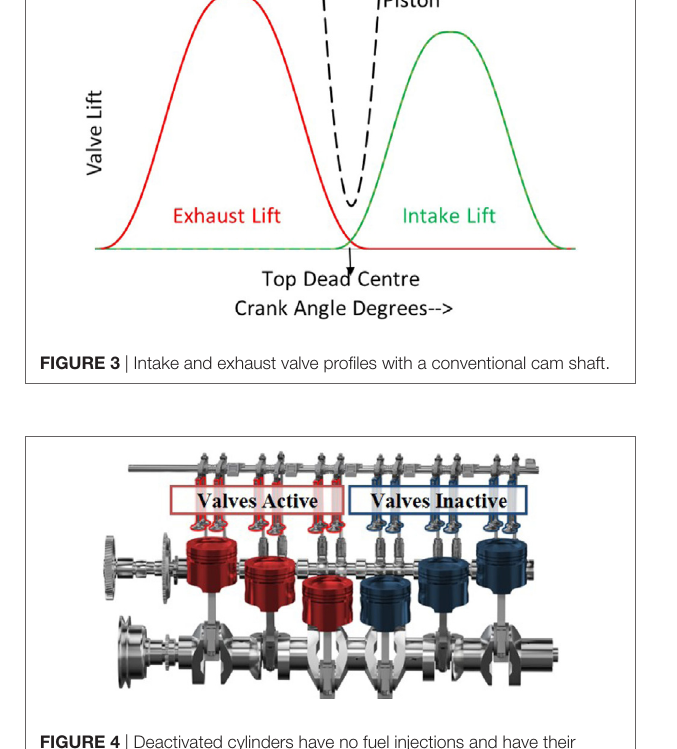
FigUre 4 | Deactivated cylinders have no fuel injections and have their valves shut during CDA. The amount of fuel injected doubles for the active cylinders in CDA to be able to meet the required brake torque.